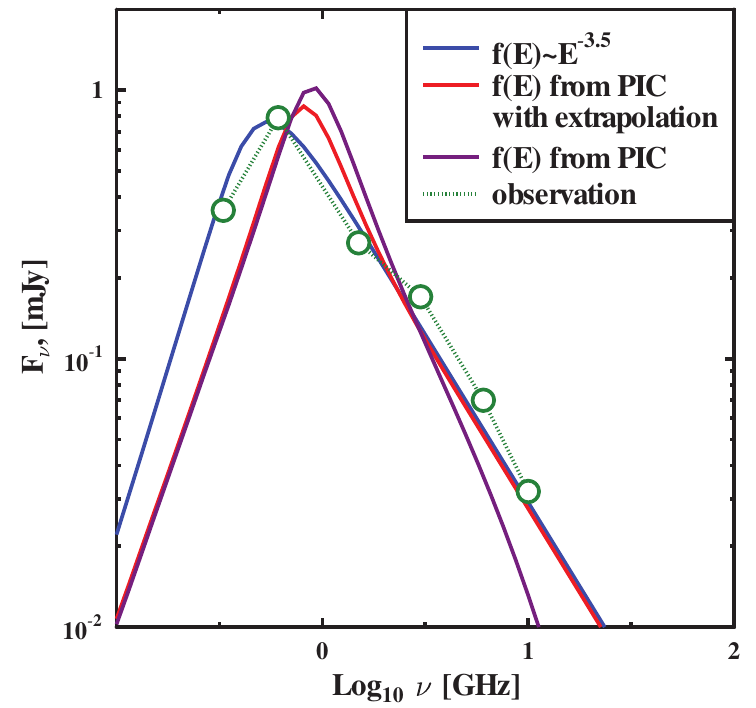
Figure 6. Observed (green circles) and modeled spectral energy distribution of CSS161010 at day 357 for various model electron